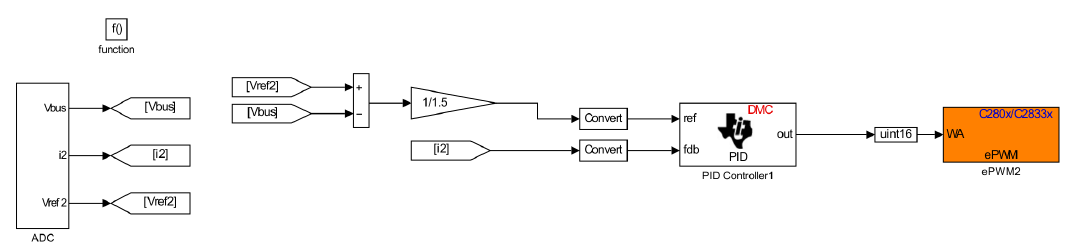
Figure 12. HIL controller for Source 2 (conventional)–traditional